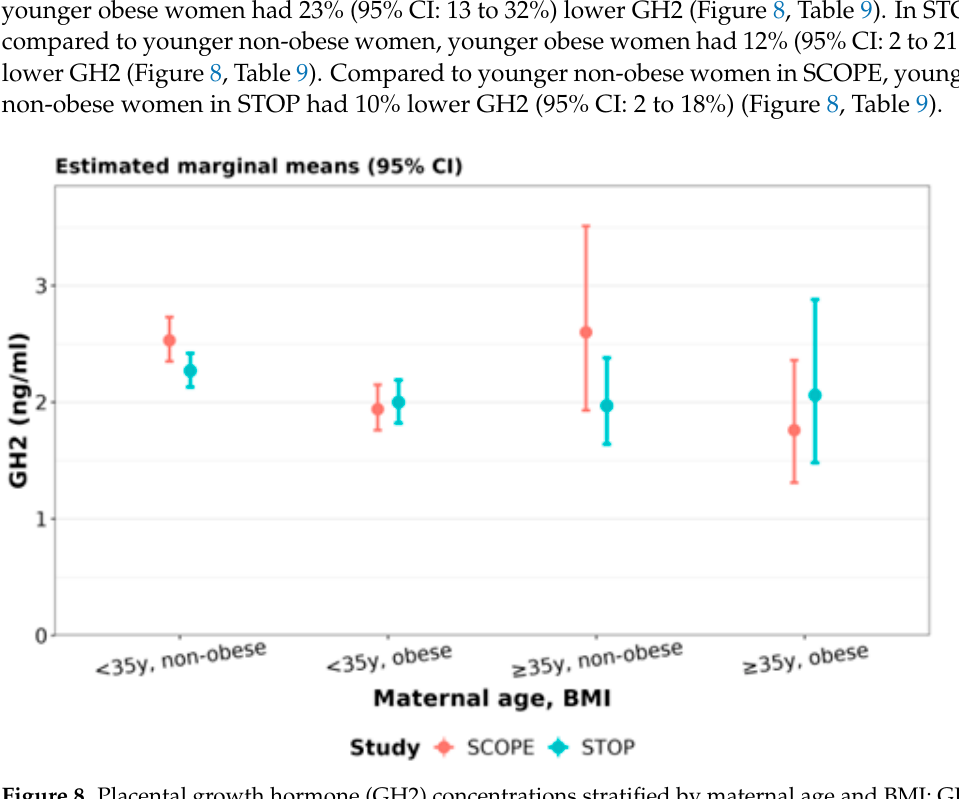
Figure 8. Placental growth hormone (GH2) concentrations stratified by maternal age and BMI: GH2 in early gestation SCOPE (N = 465) and STOP (N = 684) women was stratified by maternal age and BMI status. Women were stratified as younger than 35y or 35y and older and as non-obese (healthy BMI) or